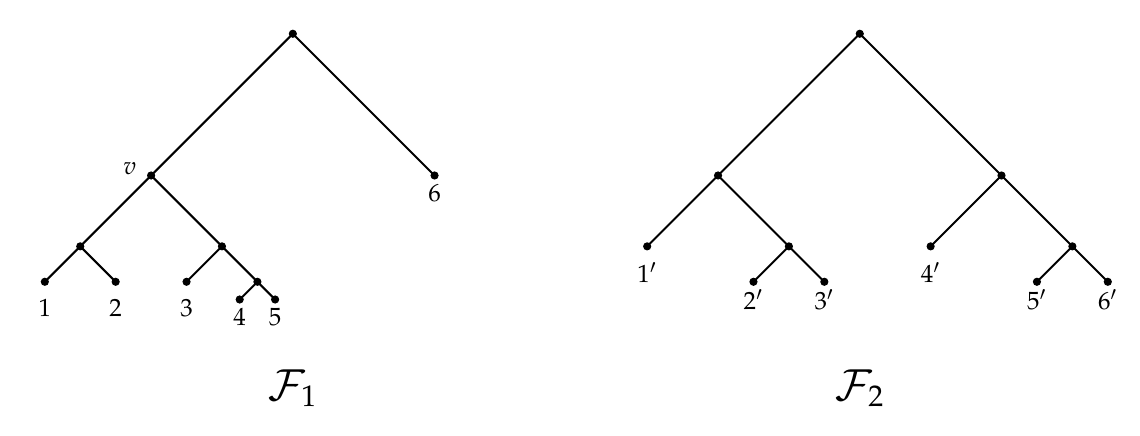
Figure 1. Pair of trees for the element x of Thompson’s group V .